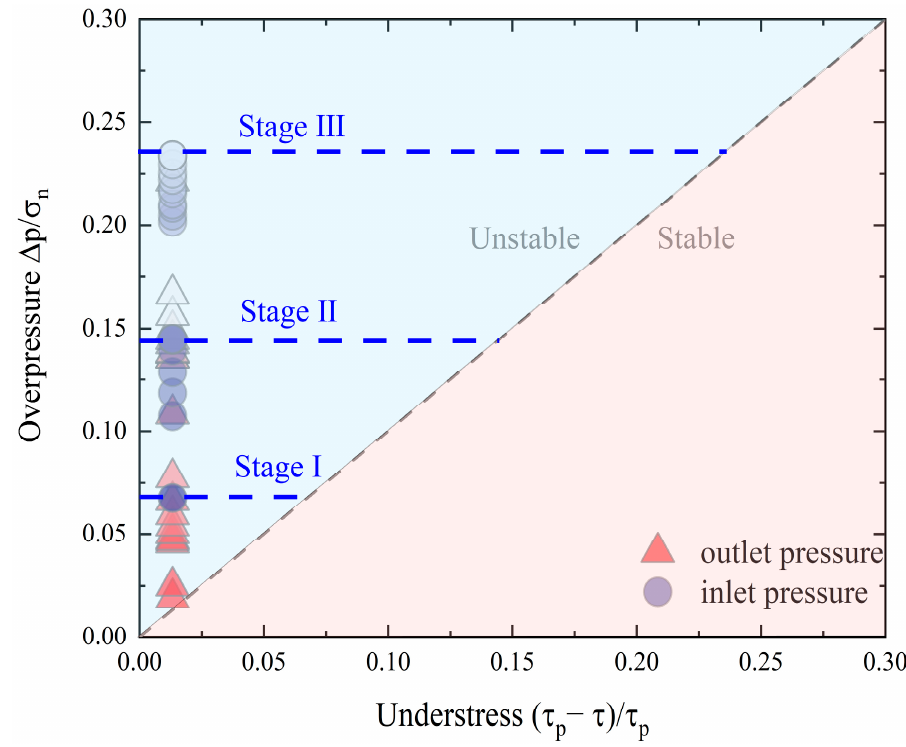
Figure 8. The overpressure and understress in the experiment.